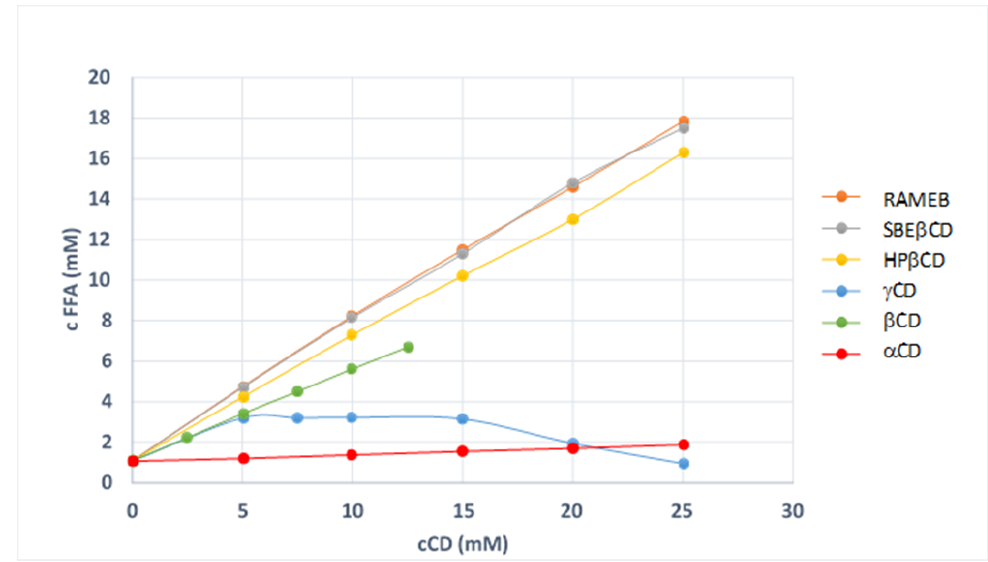
Figure 1. Phase solubility diagrams of FFA with different CDs at 37 °C in pH 6.8 phosphate buffer.